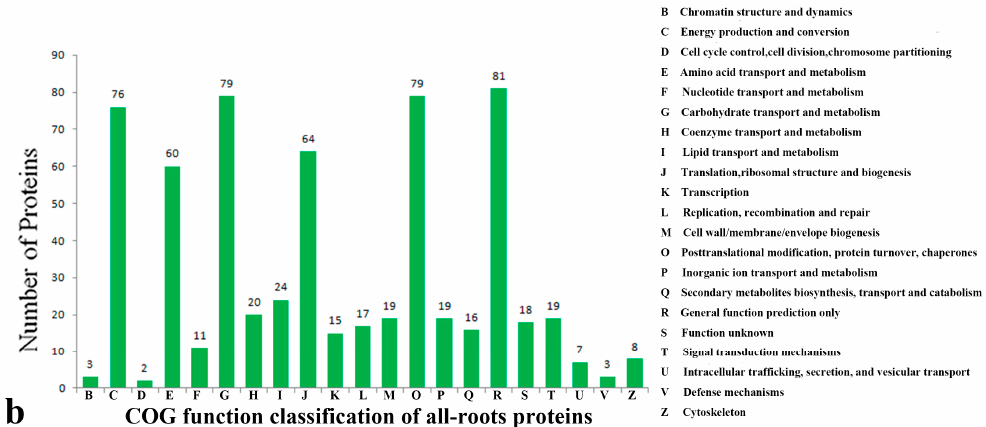
Figure 4. COG function classification of all leaf ( a ) and root ( b ) proteins.